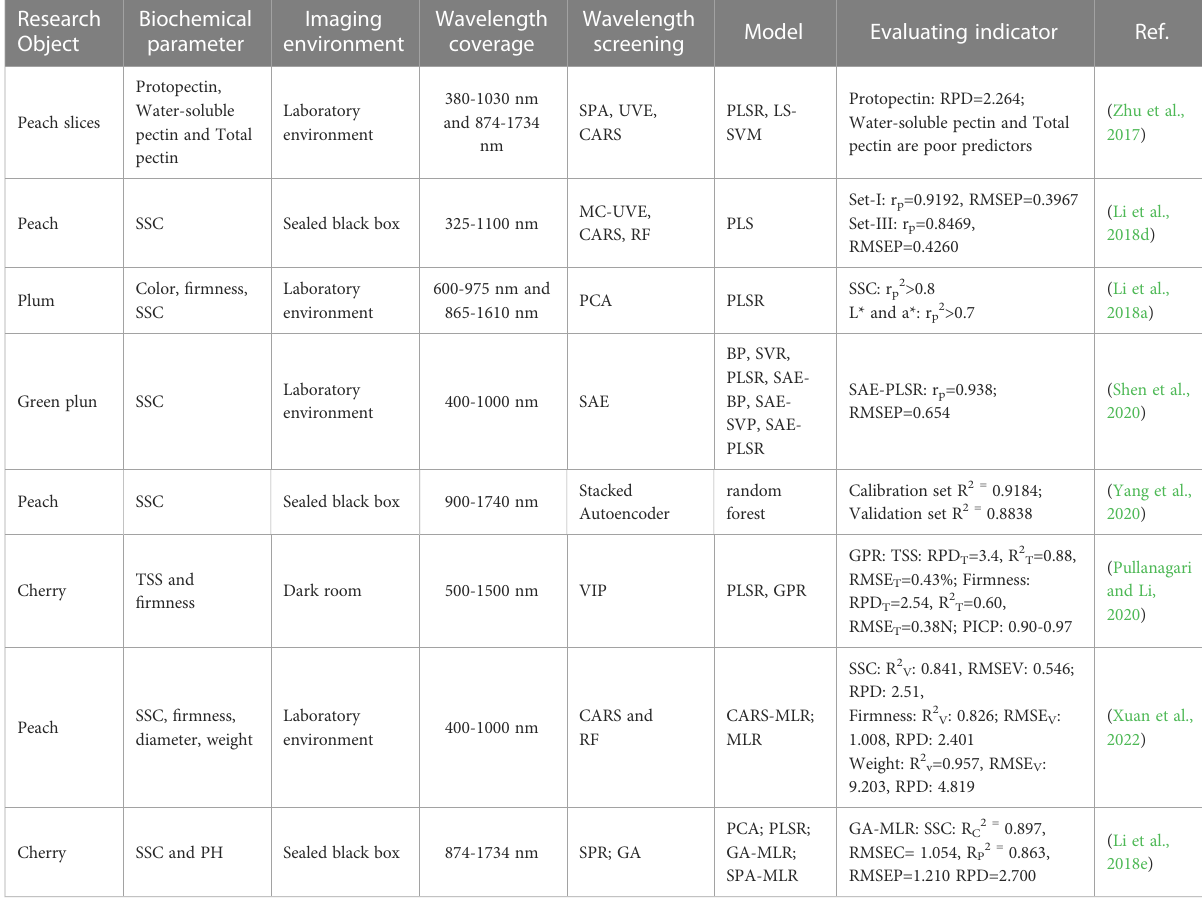
TABLE 5 Summary of fruit quality detection based on phenotypic information from hyperspectral imaging.